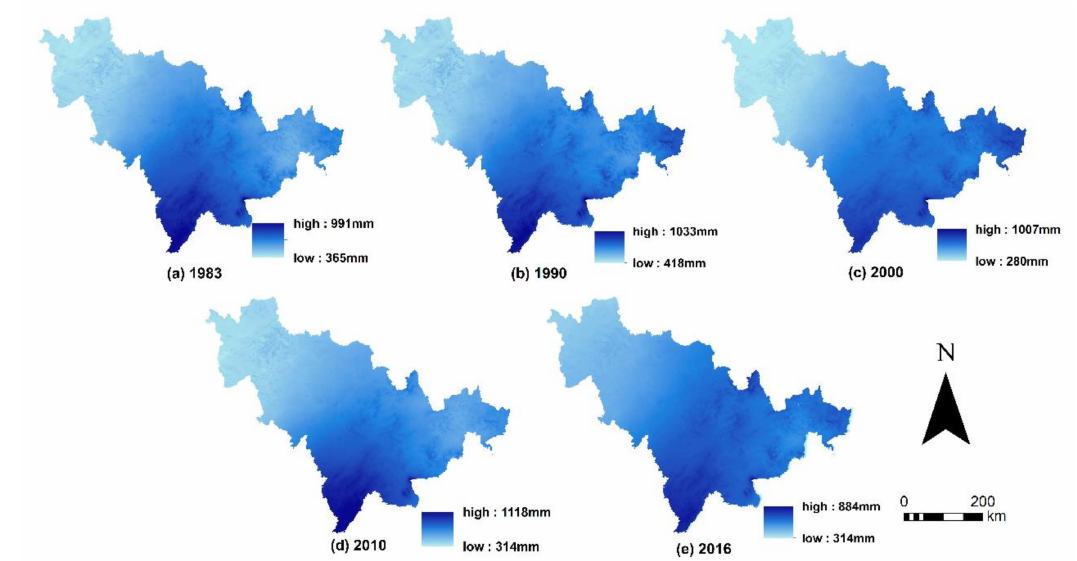
Figure 3. The spatial-temporal distribution characteristics of the P data in Jilin province in ( a ) 1983, ( b ) 1990, ( c ) 2000, ( d ) 2010, and ( e )